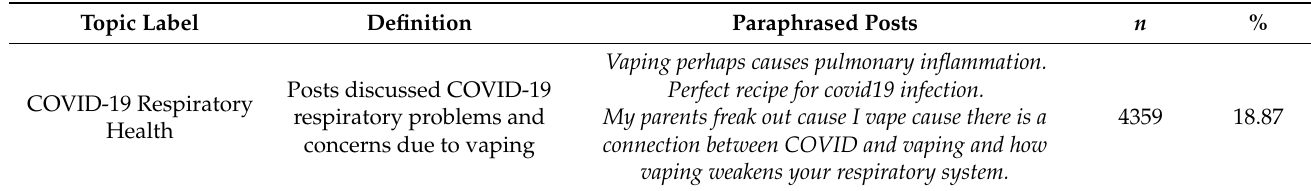
Table 1. Predominant topics referencing COVID-19 and vaping on